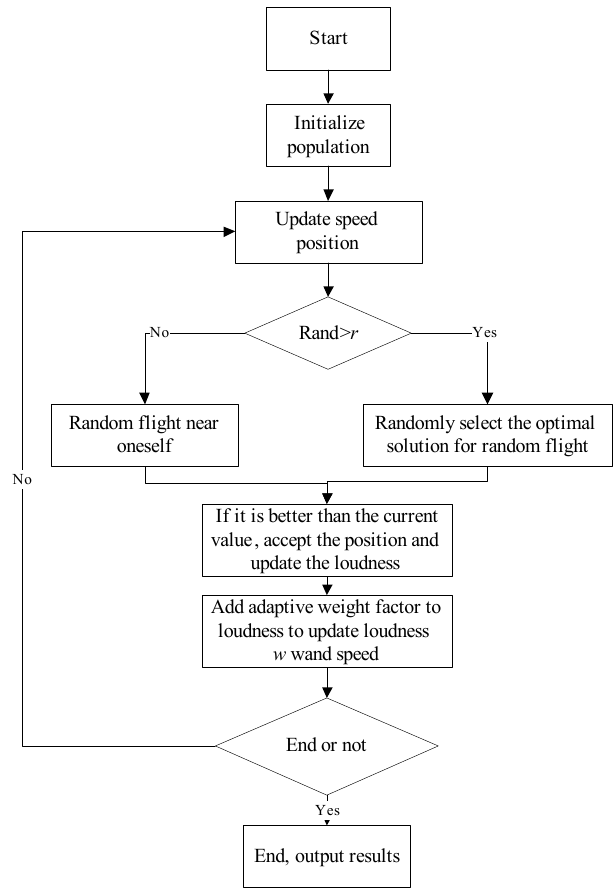
Figure 2. The flowchart of IBA algorithm.